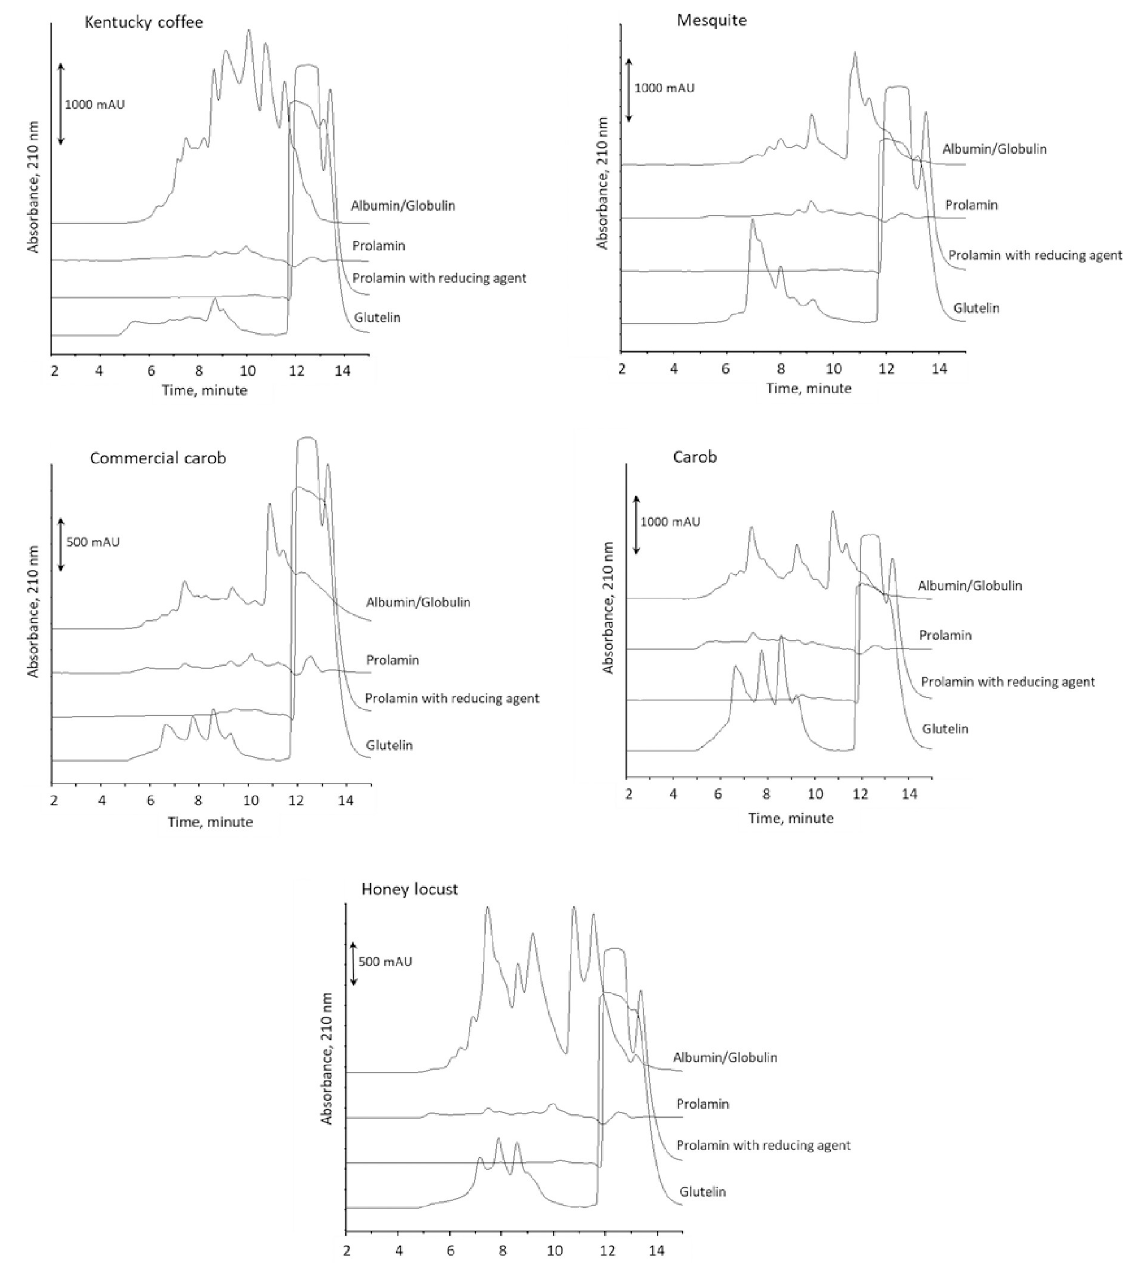
Fig 2. Size exclusion chromatograms obtained from Osborne fractionation